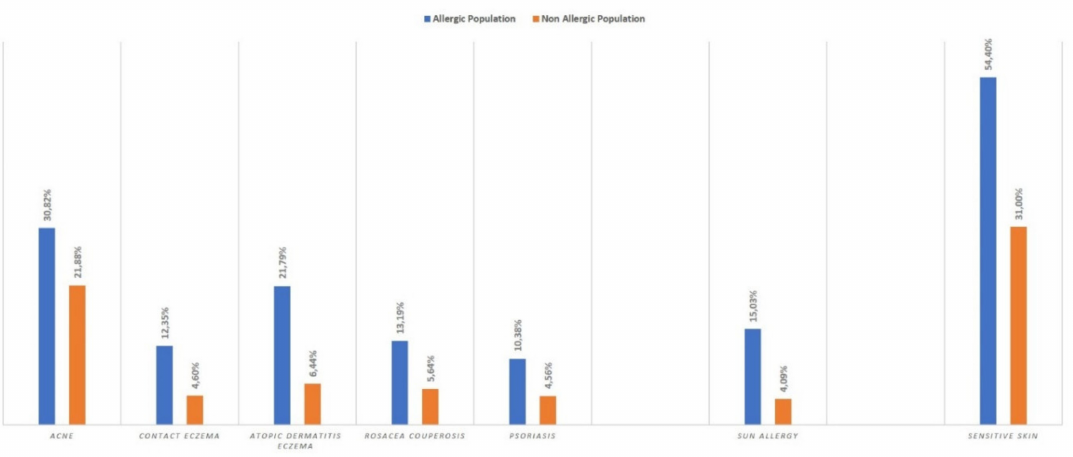
Figure 1. Skin diseases in the two